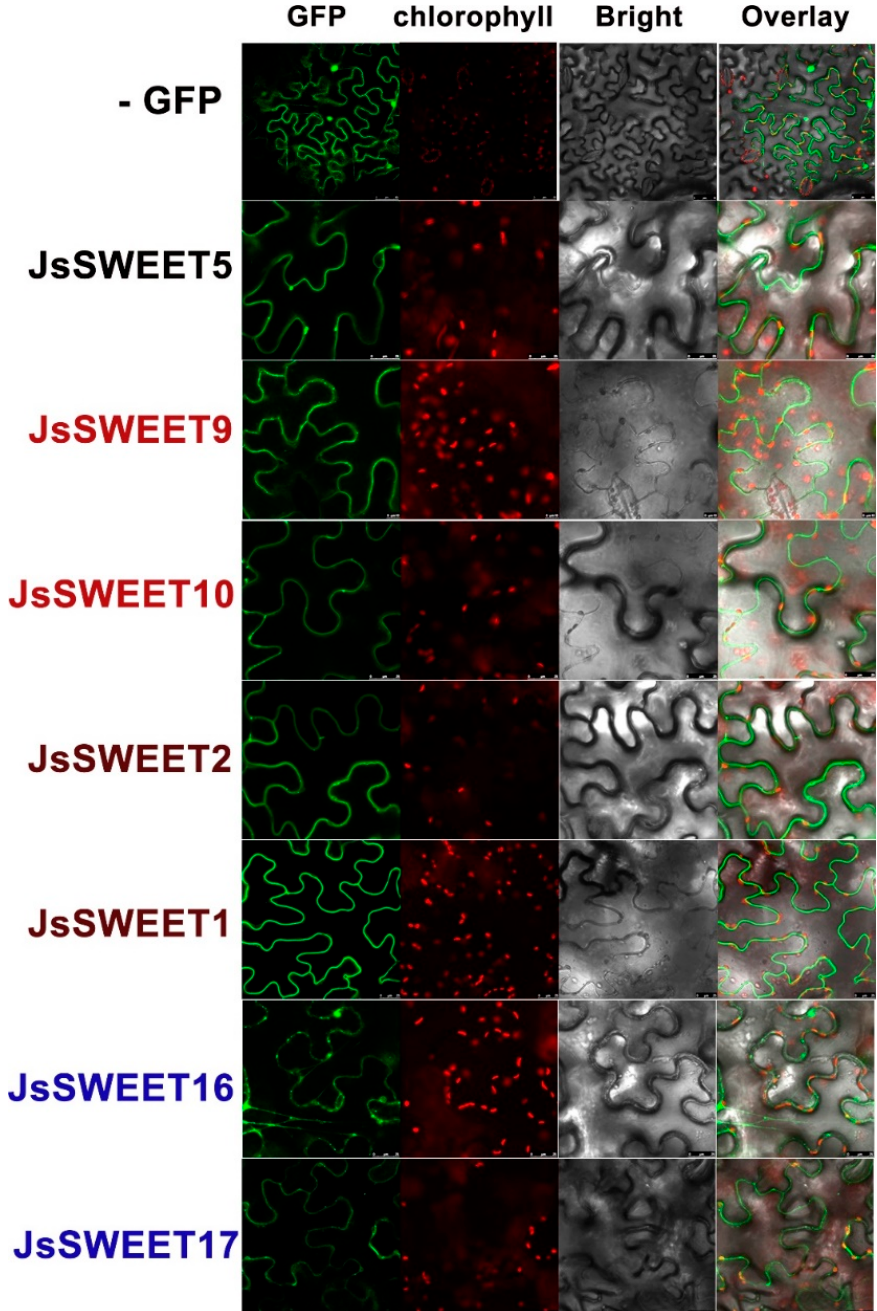
Figure 5. Transient expression of JsSWEET-GFP fusion proteins driven by the 35S promoter in N. benthamiana epidermis. Images were acquired using a Leica TCS SP8 system with wavelength setting for GFP (Ex = 488 nm, Em = 507 nm) or chlorophyll (Ex = 488 nm, Em = 681 nm). Gene names colored for clade-specific members (brown for Clade I, black for Clade II, red for Clade II, and blue for Clade IV). Scale bars, 25 (GFP control) or 50 (the rest) μ m.